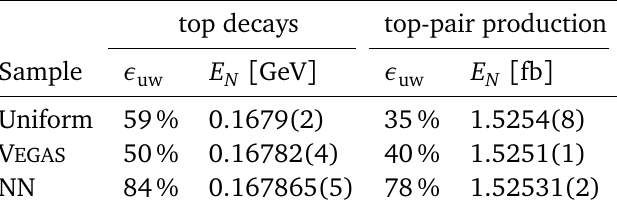
Table 1: Results for sampling the partial top-quark decay width and the total cross section of top-pair production, i.e. the Monte Carlo integral E Γ and σ for e + e − → γ → t [ be + ν t → be + ν e Besides E and its MC error, we also show the unweighting efficiency ε N sample, comparing V EGAS optimisation, NN-based optimisation and an unoptimised (“Uniform”) distribution. All samples consist of N = 10 6 (weighted)